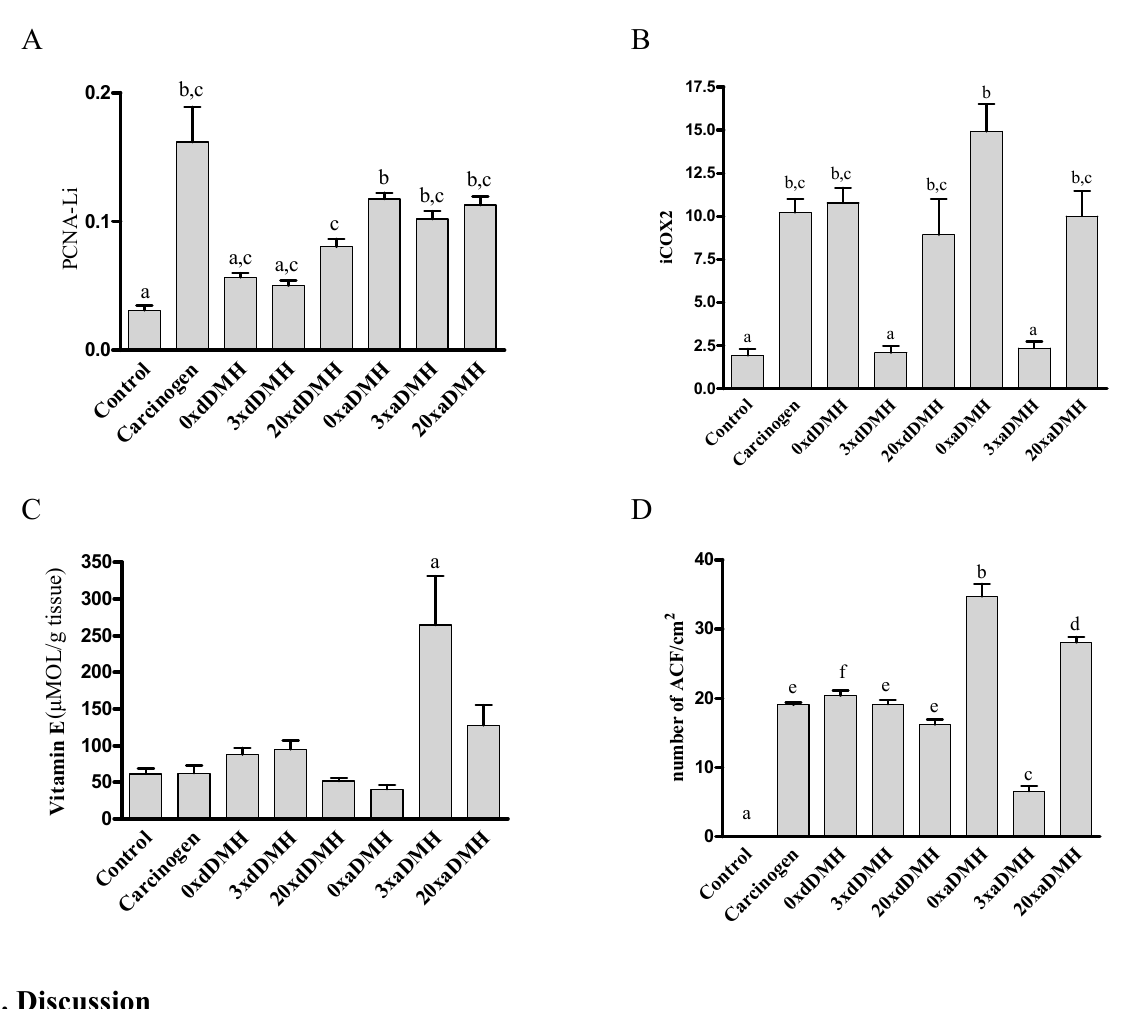
Figure 4. Colonic expression of PCNA and COX-2 obtained by immunohistochemistry, hepatic content of VE measured by HPLC, and ACF count obtained by H & E. Statistical analysis. ( A ) PCNA labeling index (PCNA-Li). ( B ) Cyclooxygenase 2 index (iCOX-2). ( C ) Hepatic content of VE. ( D ) Number of ACF. a p < 0.05 compared to Carcinogen, 0×aDMH, 3×aDMH, 20×aDMH; b p < 0.05 compared to Carcinogen, 0×aDMH, 3×aDMH, 20×aDMH and 20×dDMH; c p < 0.05 compared to Carcinogen, 0×dDMH, 0×aDMH, 20×dDMH and 20×aDMH; d p < 0.05 compared to 0xaDMH; e p < 0.05 compared to other groups; f p < 0.05 compared to